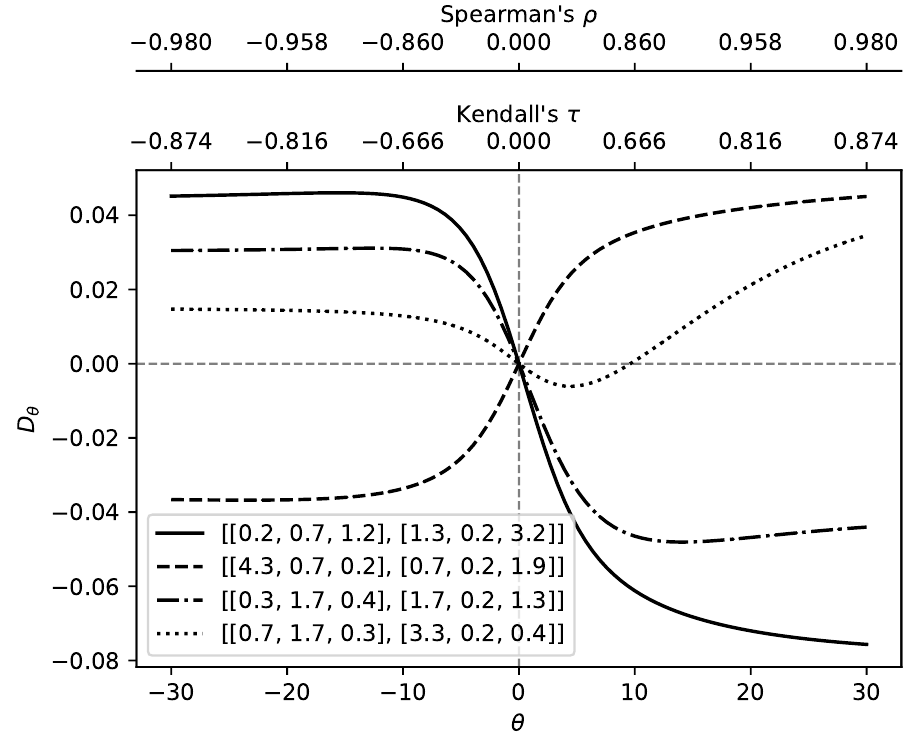
Figure 1. Values of D θ for different random